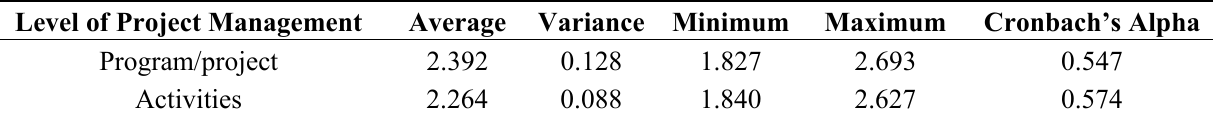
Table 3. Comparison of averages between the two levels of project management in Serbian energy companies